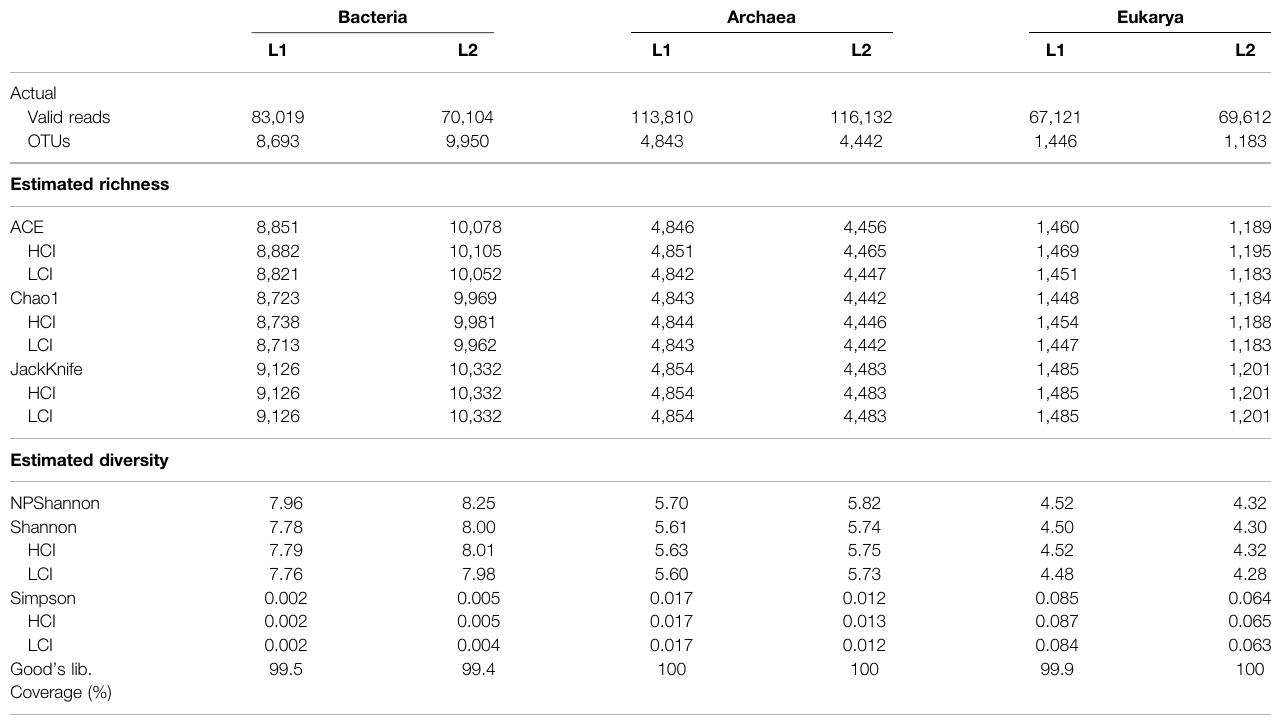
TABLE 3 | Alpha diversity of microbiome evenness, richness, and varieties of species in the sediments.